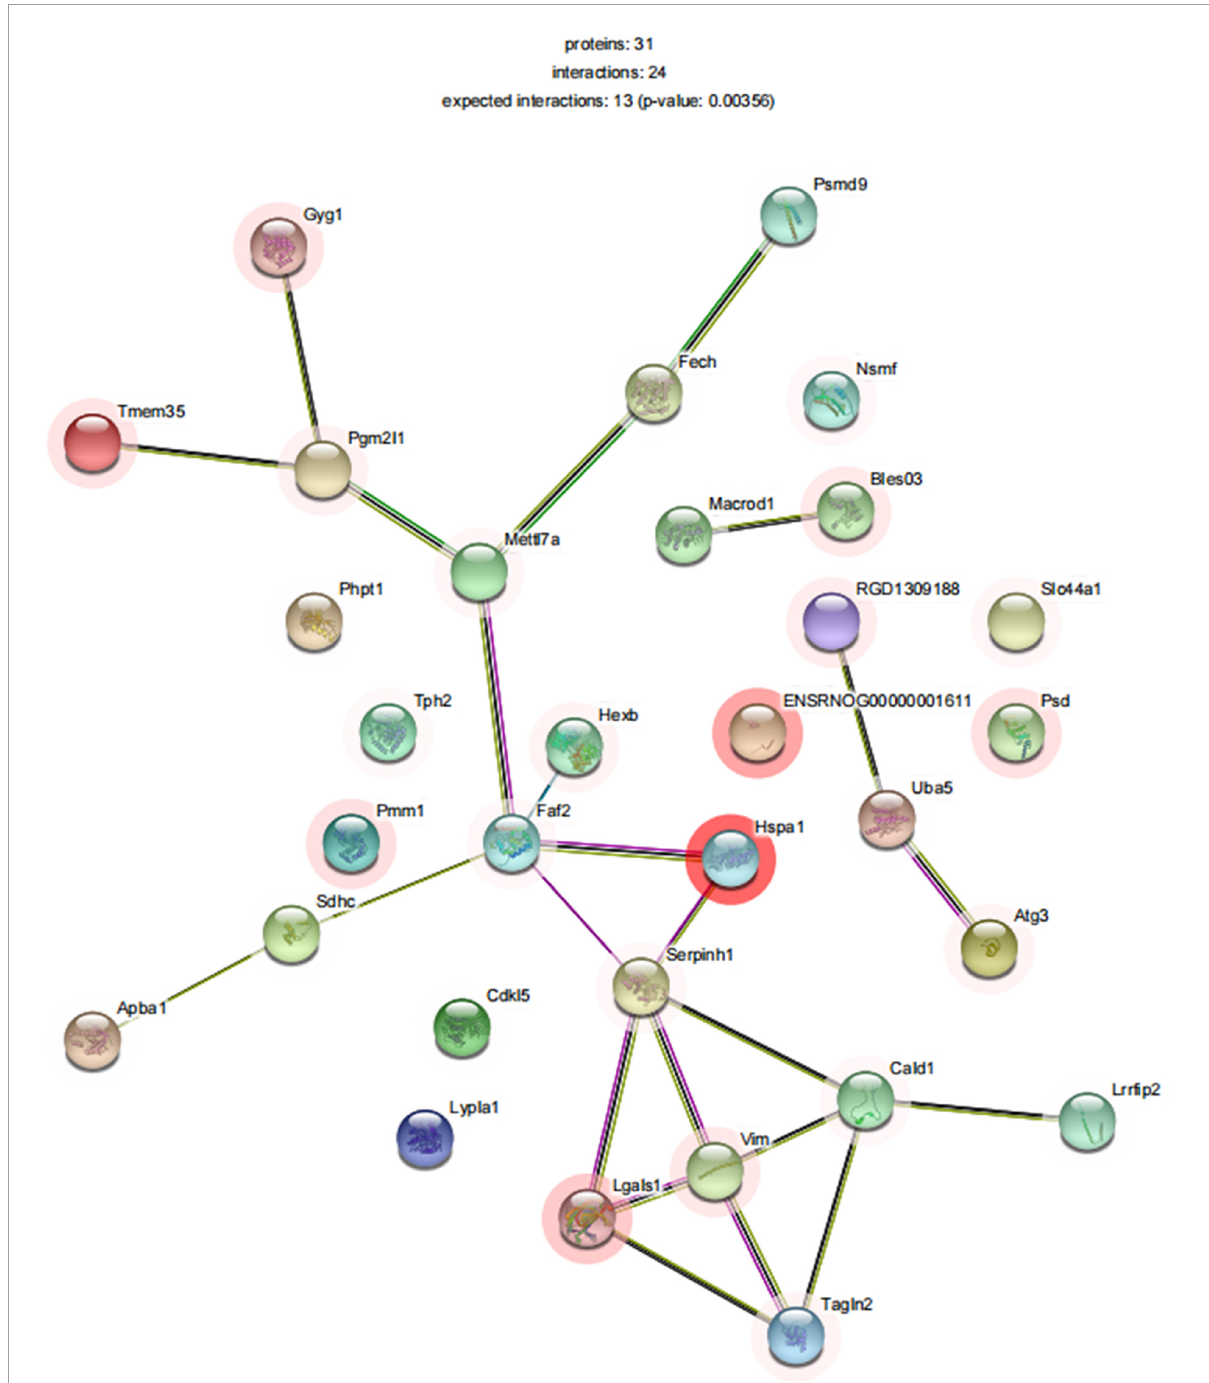
FIGURE9 STRINGdb protein–protein network enrichment analysis. The protein–protein interaction network of significant proteins is shown. STRING database integrates various information from curated databases that were experimentally determined; gene neighborhood, gene fusions, and gene co-occurrence; text mining, co-expression, and protein